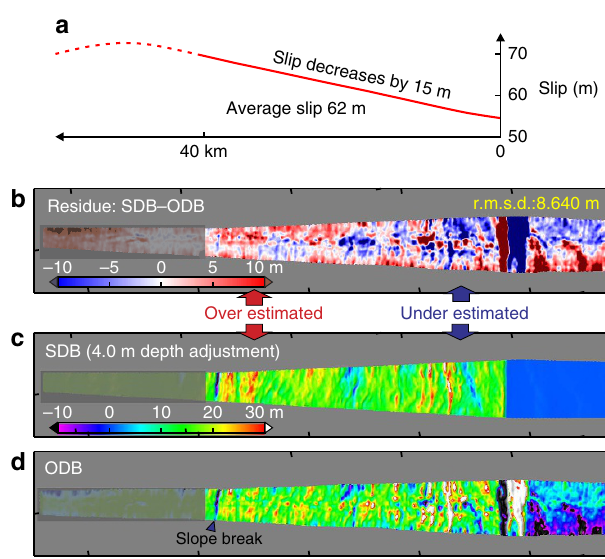
Figure 7 | Testing SDB model for the central corridor with large trenchward decrease in fault slip. Otherwise the figure is similar to Fig. 3. ( a ) Fault slip distribution over the most seaward 40km. ( b ) Residue between the SDB ( c ) and 1999–2011 ODB ( d ) showing underestimate of differential bathymetry near the trench but overestimate away from the trench. ( c ) SDB produced using the slip distribution shown in a and optimal depth adjustment 4.0m. ( d ) 1999–2011 ODB.